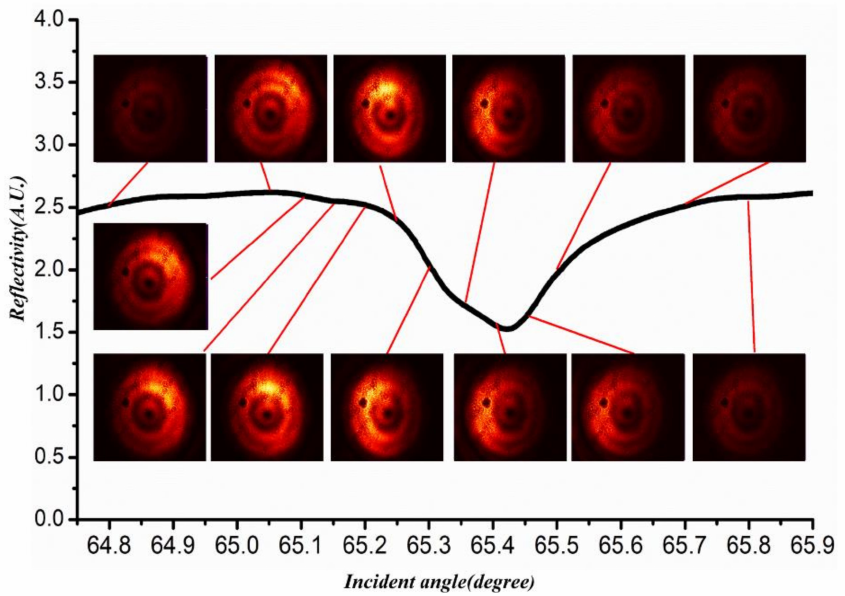
Figure 6. Goos-Hänchen shift of a transmitted vortex beam with topological charge l = 1 in one resonance period. The succession of beam profiles is normalized to the highest intensity during the process of resonance for a better view of the evolution of the transmitted